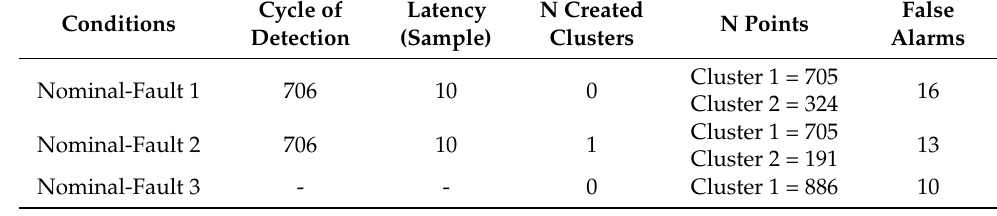
Figure 13. Selected features (sealing group). Table 9. Performances of AAD + ADP (sealing group).